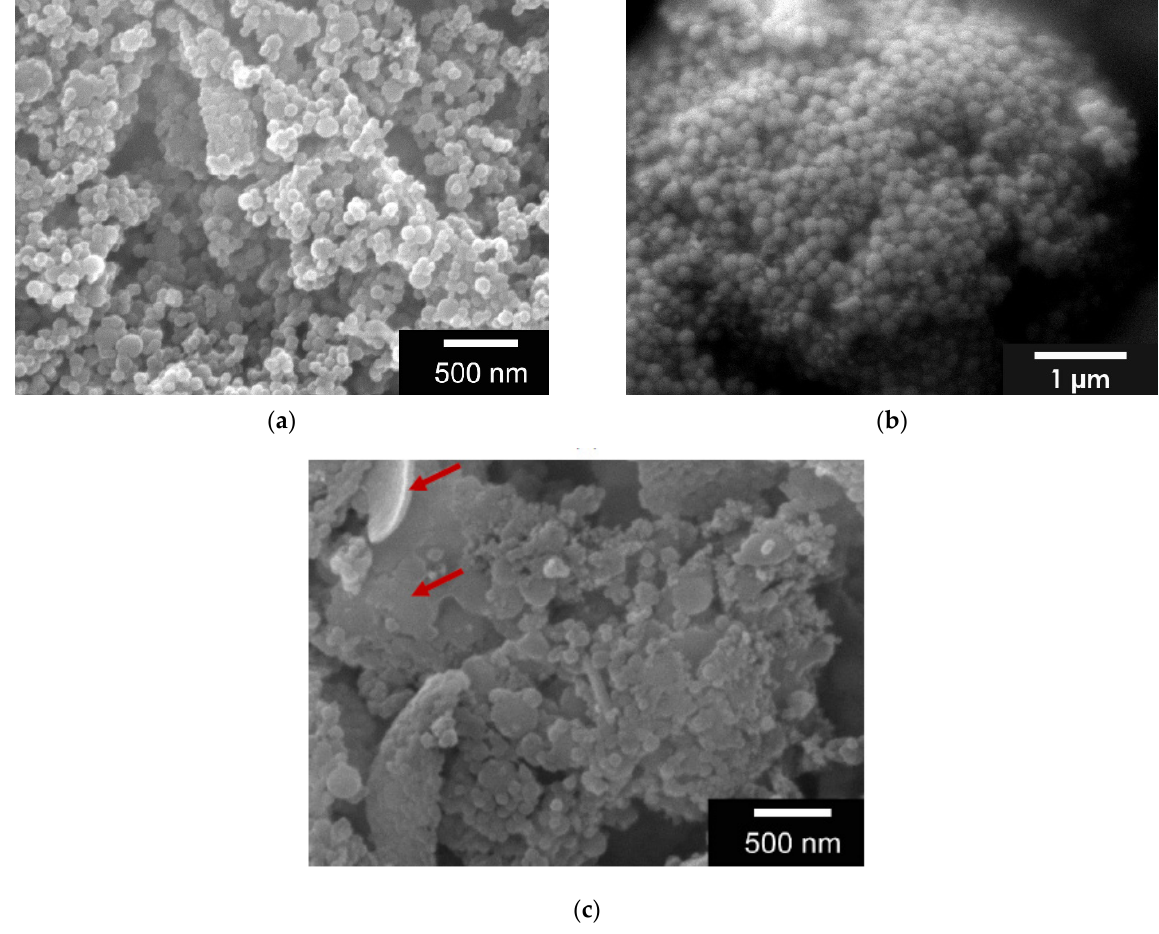
Figure 1. ( a ) ESEM Images of GNPs at a pH 2.0 which leads to GNPs smaller than 100 nm; ( b ): pH 2.5 with well-shaped GNPs having a size of 100 nm and ( c ): pH 3.0 with non-uniform size and shape of the GNPs, as well as structures not representing GNP (red arrow) Images taken with FEI Quanta 250 FEG at 12 kV acceleration voltage, all samples were sputter coated (JEOL, JFC-1200) with a 25 nm Gold layer.